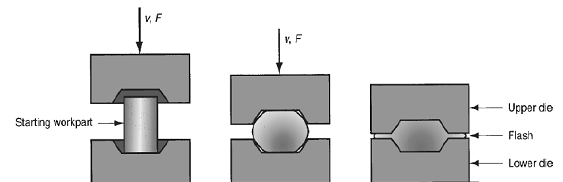
Figure 2: Closed die or impression die-forging from starting point until finish [5]